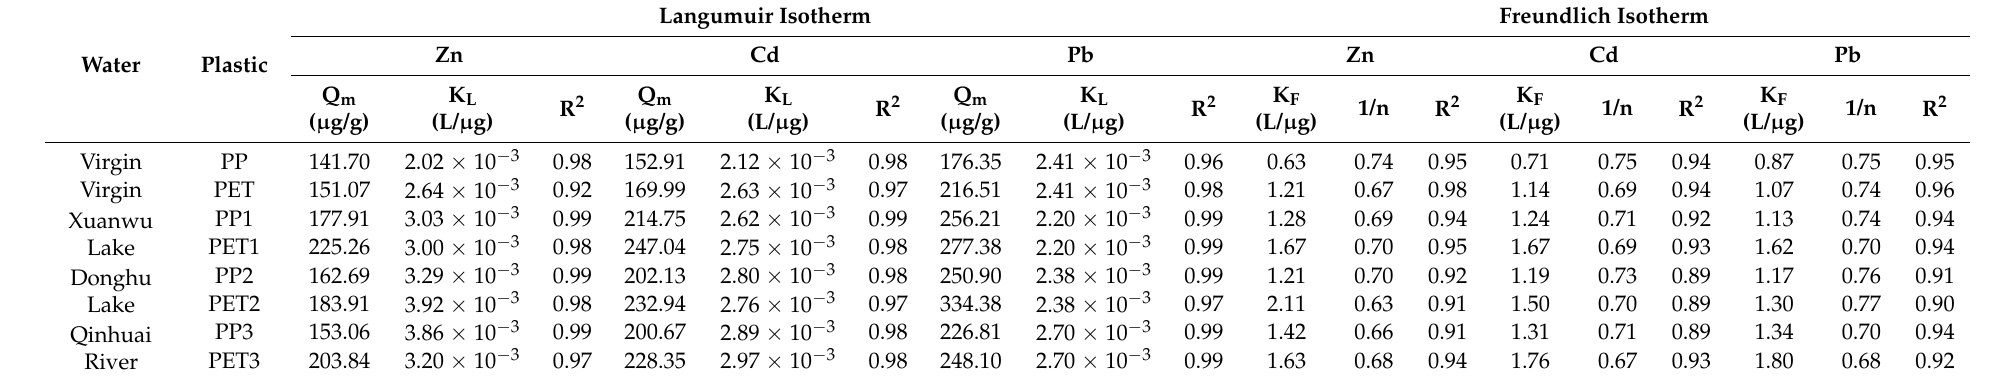
Table 1. Parameters of Langmuir adsorption isotherm and Freundlich adsorption isotherm models used in the